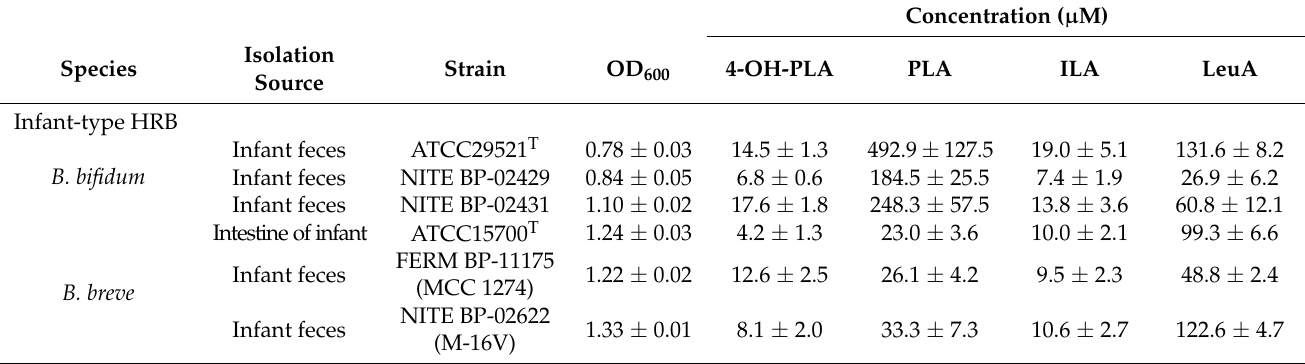
Table 1. Production of HCA 3 ligands in culture supernatants of Bifidobacterium